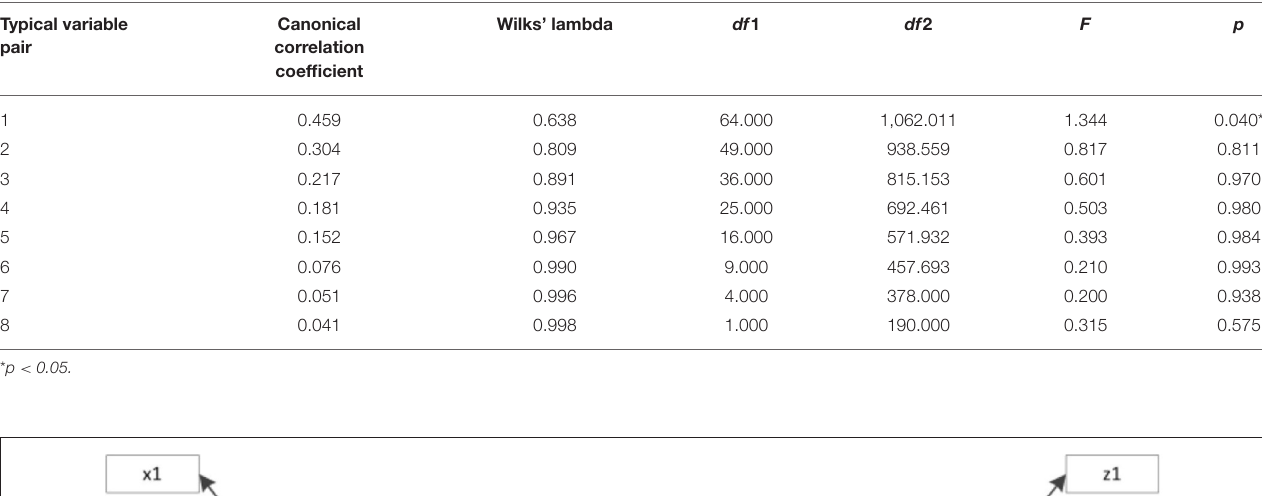
TABLE 5 | Typical correlation coefficients and significance of motor behavior and motor development.